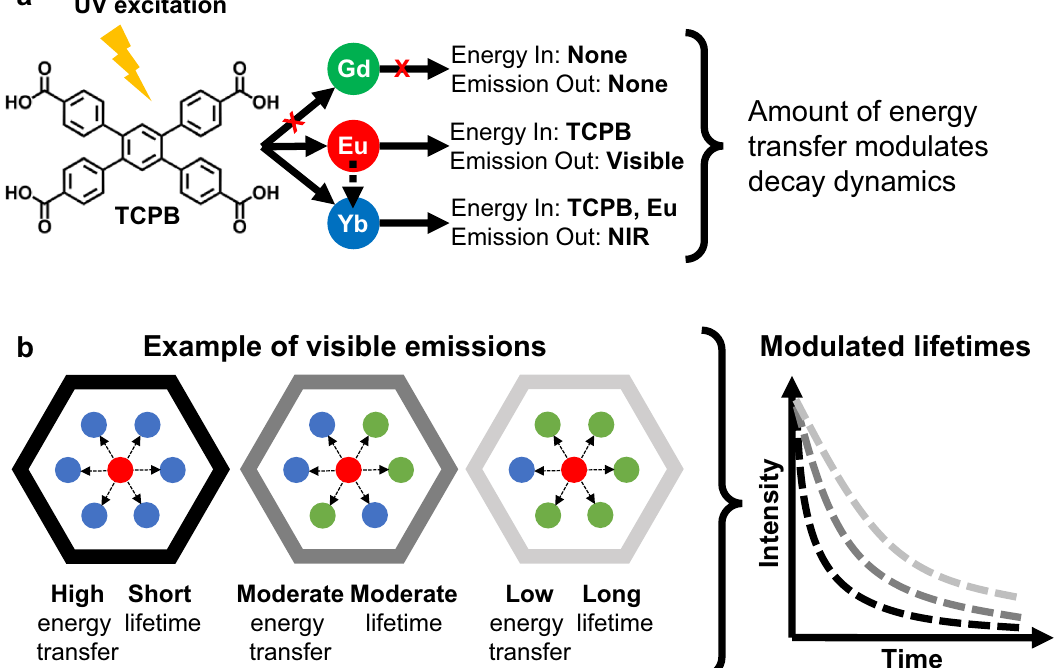
Fig. 1 | Concept of controllable energy transfer for lifetime modulation in EuGdYb-based trimetallic compositions. a Direct ligand excitation results in modulatedenergytransfer,illustratingtherelationshipsbetweeneachcomponent.